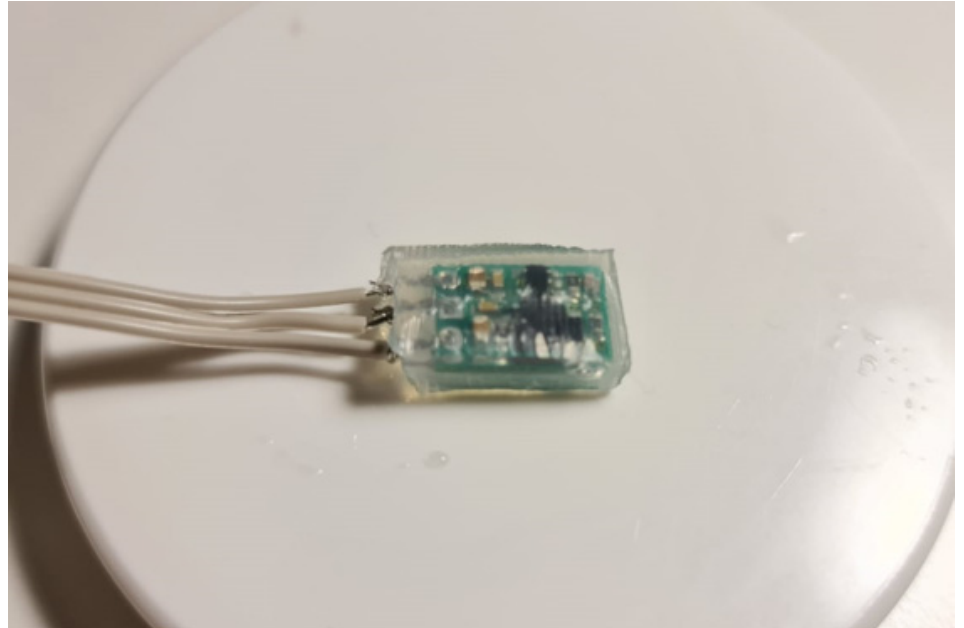
Figure 3. RTV 9161 elastomer-encapsulated device.